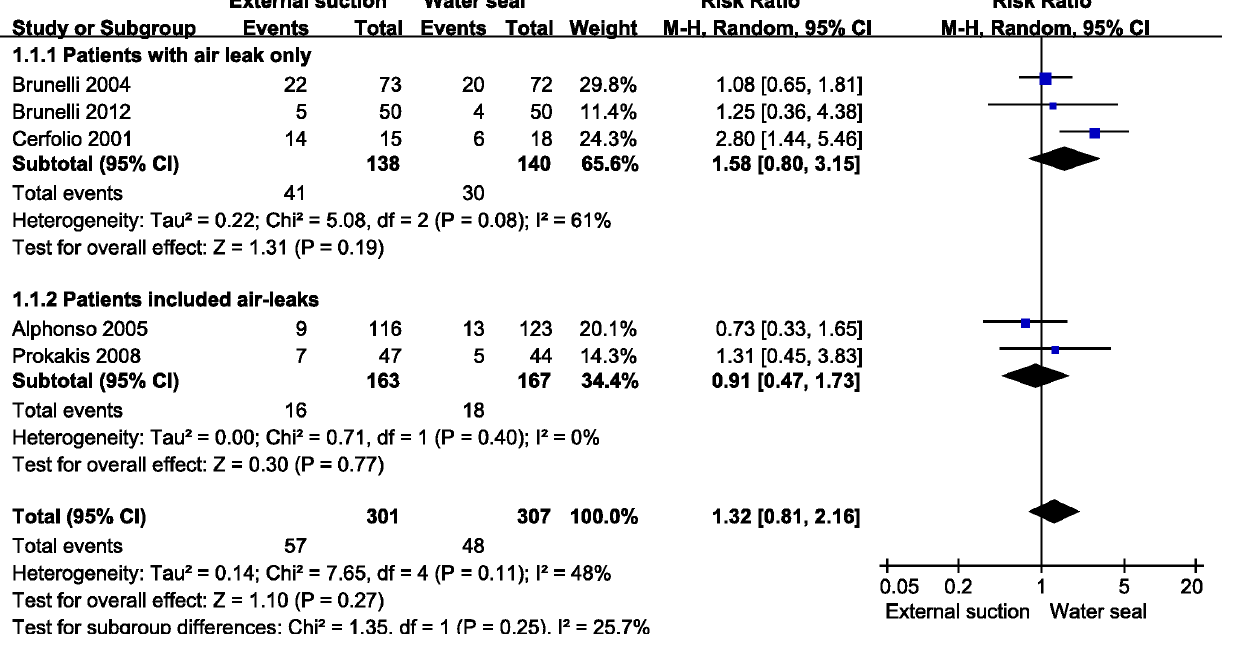
Figure 3. Meta-analysis of external suction versus water seal on the incidence of PAL. Subgroup 1: patients with air leak only. Subgroup 2: patients included air-leaks. M-H, Mantel-Haenszel. Events means patient with PAL.